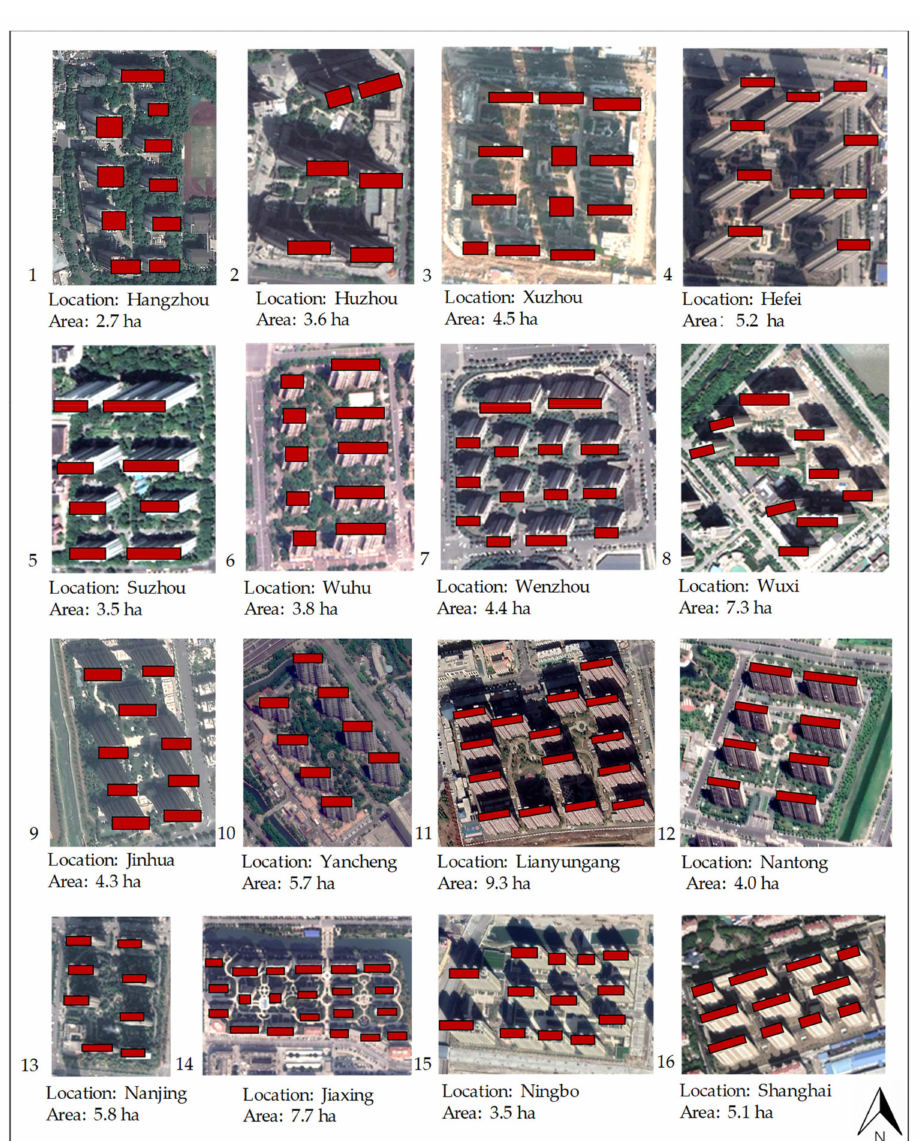
Figure 3. Site layouts of 16 high-density districts in the Yangtze River Delta region of